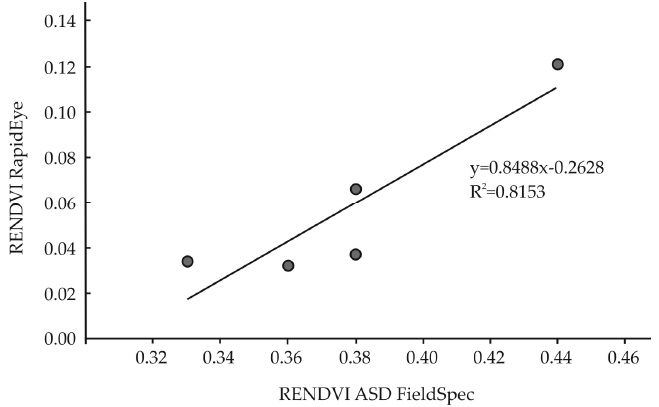
LYR/SVH; Dryas octopetala —BOL and FLY; Salix Polaris —IBJ and FLY. The highest heavy metal values in vegetation and soil were found at the SVH, FLY and BOL sites while the lowest were found at LYR and IBJ (Table 8). The heavy metal concentrations in the plants are significantly lower compared to the upper layers of the soil (Table 8).